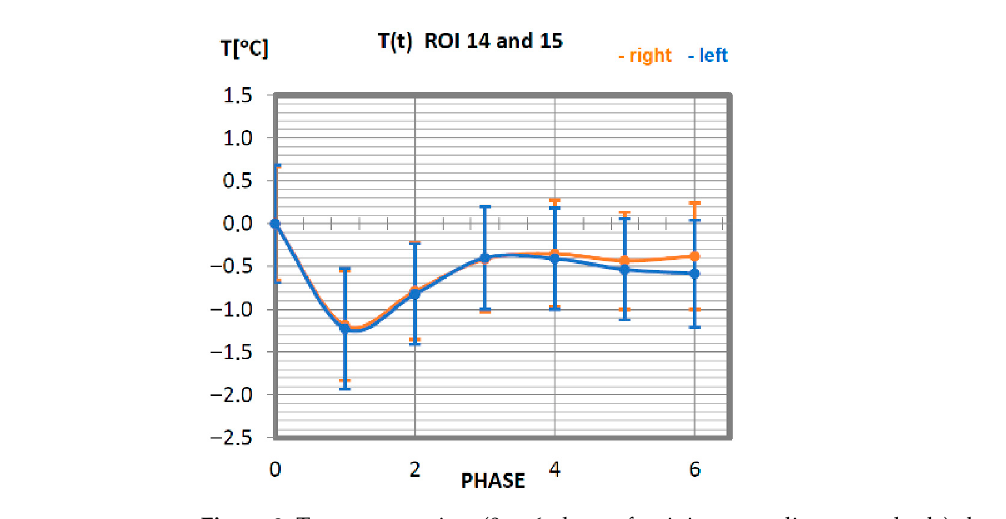
Figure 9. Temperature time (0 to 6 phase of training according to methods) changes of the gastrocnemius muscle obtained before and after training using a rowing ergometer for the studied group of athletes.